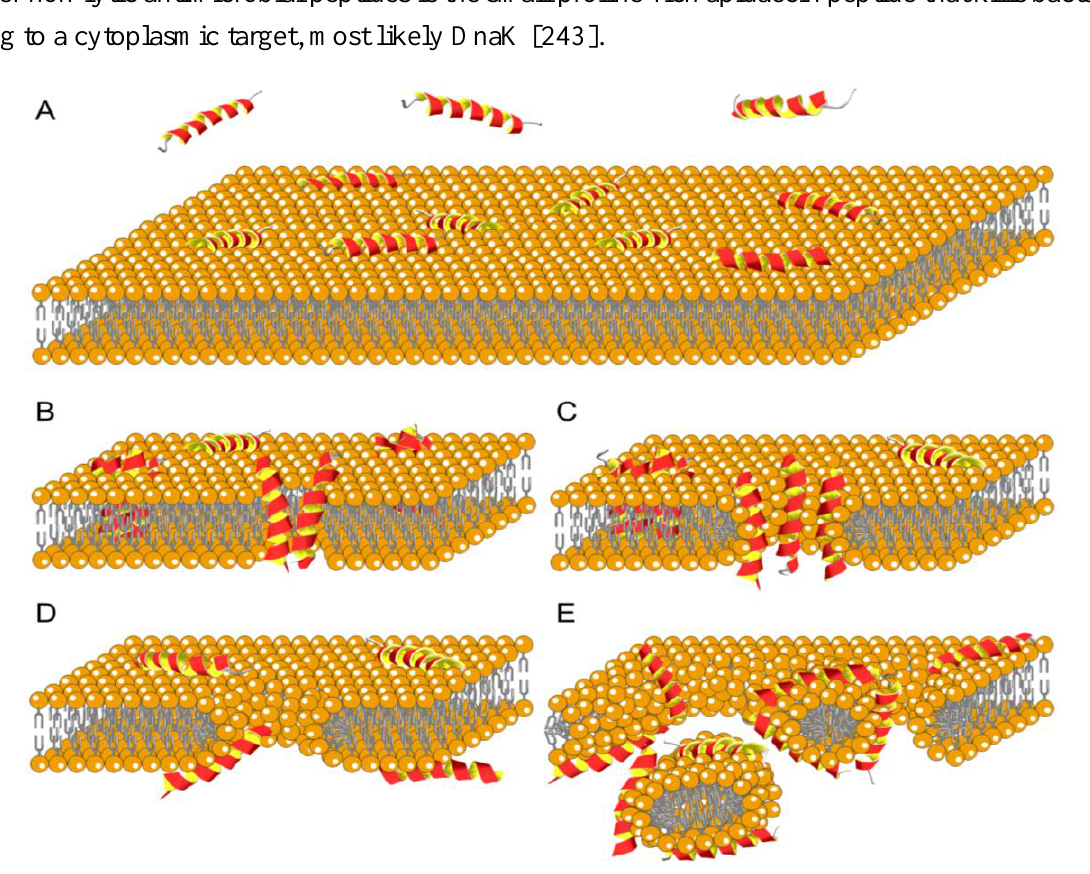
the reader are refereed to